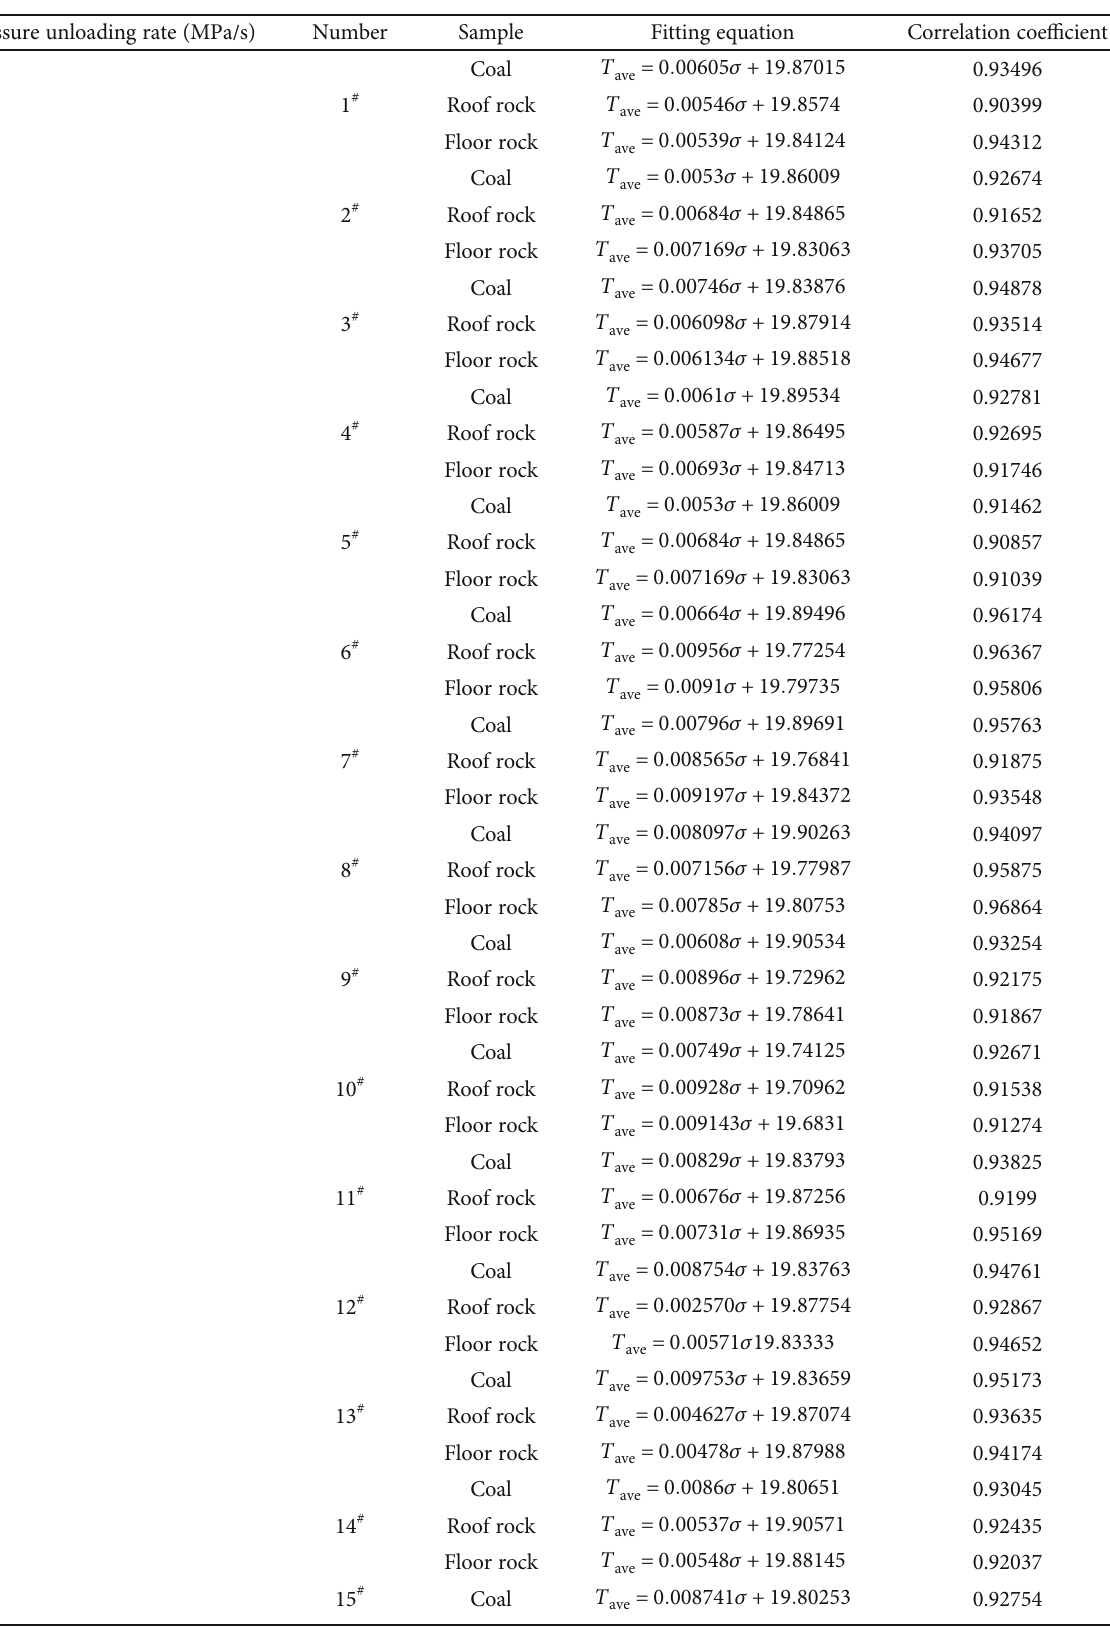
Table 4: Fitting equations at di ff erent pressure release